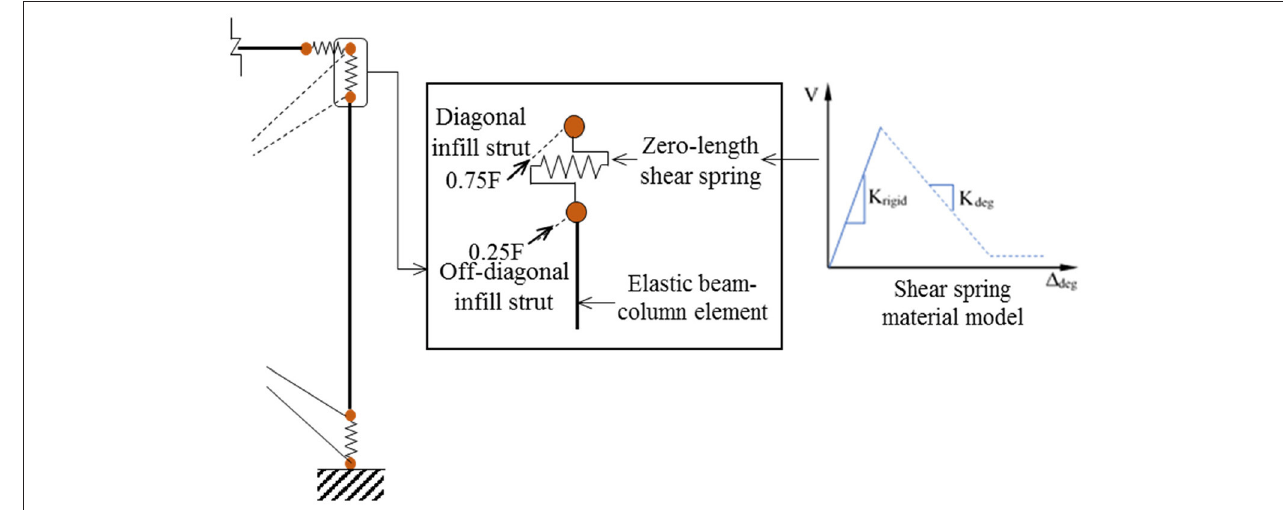
FIGURE 4 | Spring model for column shear